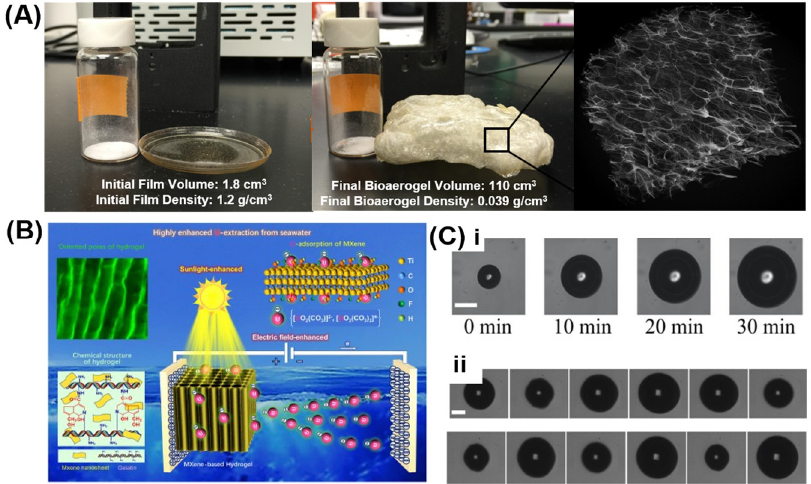
Figure 7. Gelatin foam enhancement. ( A ) Microwave-assisted fabrication of gelatin foams before and after microwaving at 700 W for 30 secs, with a view of the foam structure [116]. ( B ) The chemical structure and electric field/sunlight highly enhanced the uranium-adsorbing mechanism of the wood-mimetic directional macro-porous MXene-based hydrogel [117]. ( C ) ( i ) Bubbles generated by focusing a laser pulse into a 6 wt% gelatin gel supersaturated with dissolved air and ( ii ) finite-amplitude spherical oscillations of a bubble in the 6 wt% gelatin gel under 28 kHz ultrasound irradiation; the scale bar represents 100 μm [118]. (Images ( A – C ) are licensed under CC BY 4.0 (http://creativecommons.org/licenses/by/4.0/ (accessed on 30 October 2022))).